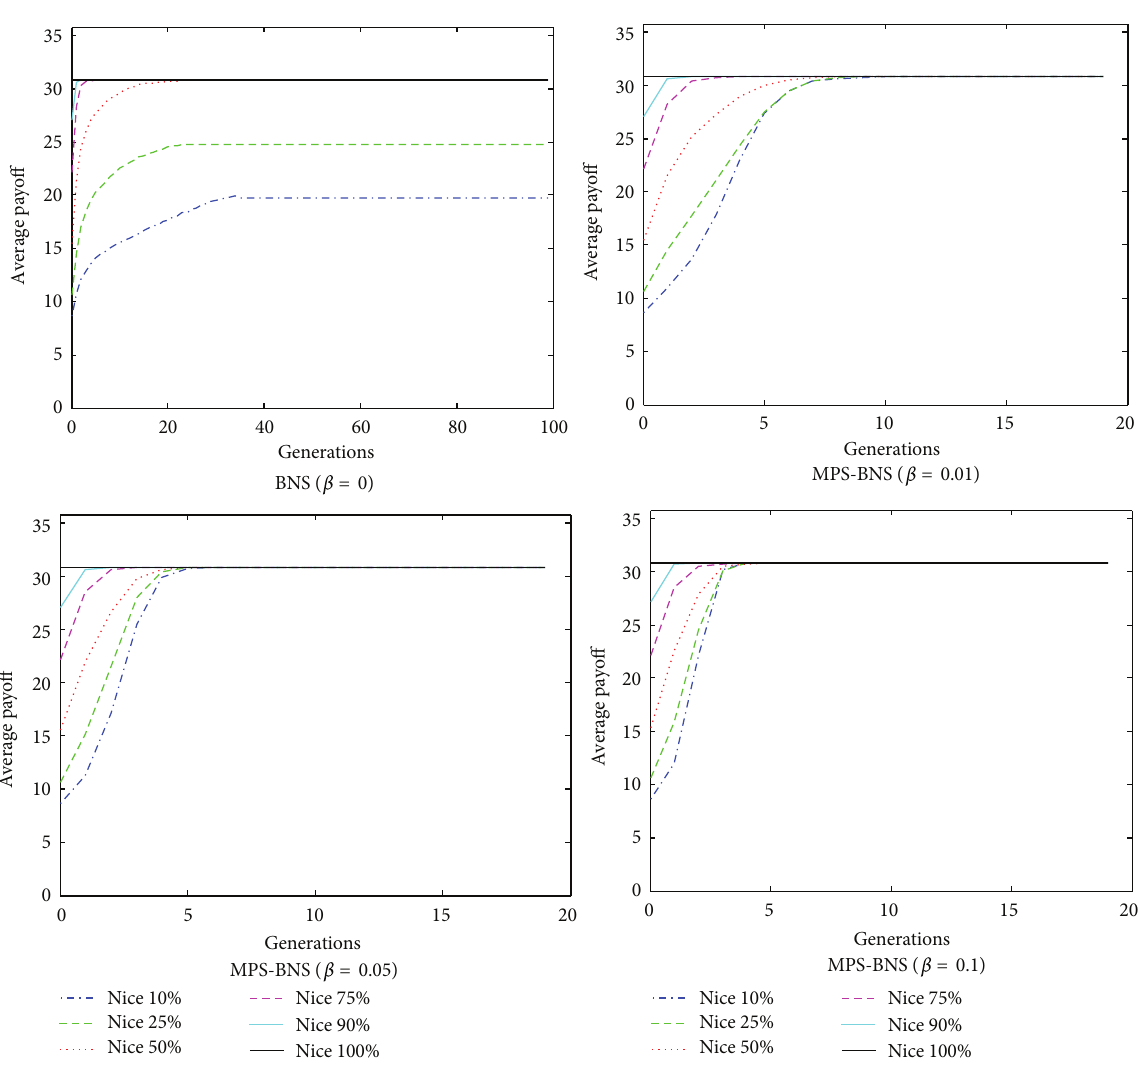
T 3: Payoff matrix of player 1 in the state (1,1).